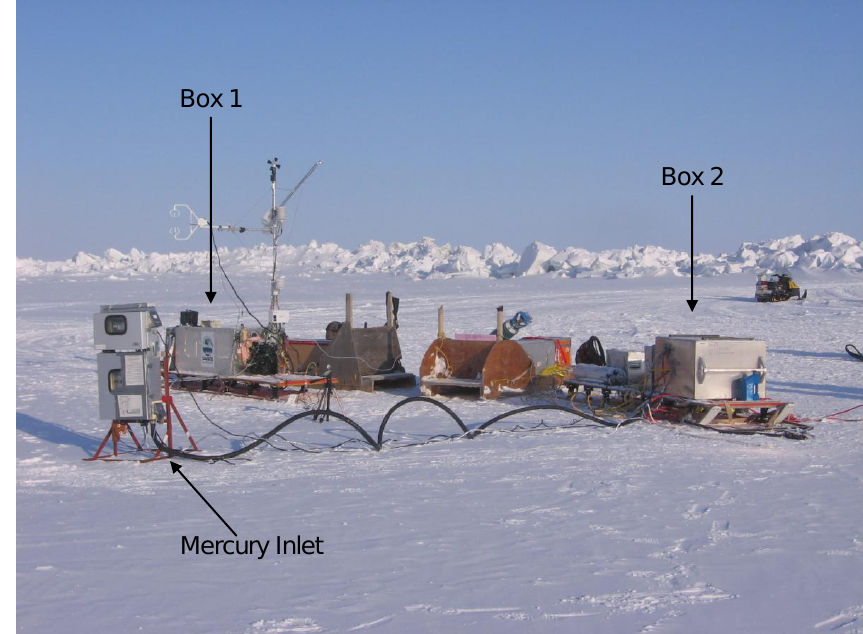
Fig. 1b. Experimental set-up of the Out On The Ice (OOTI) system. Box 1 housed the meteorological, MAX-DOAS and ozone instrumenta- tion. Box 2 housed the mercury instrumentation. The inlet for the atmospheric mercury measurement is